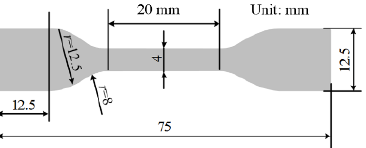
Figure 3. Configuration of XPLE dumbbell-shaped specimen for tensile test.